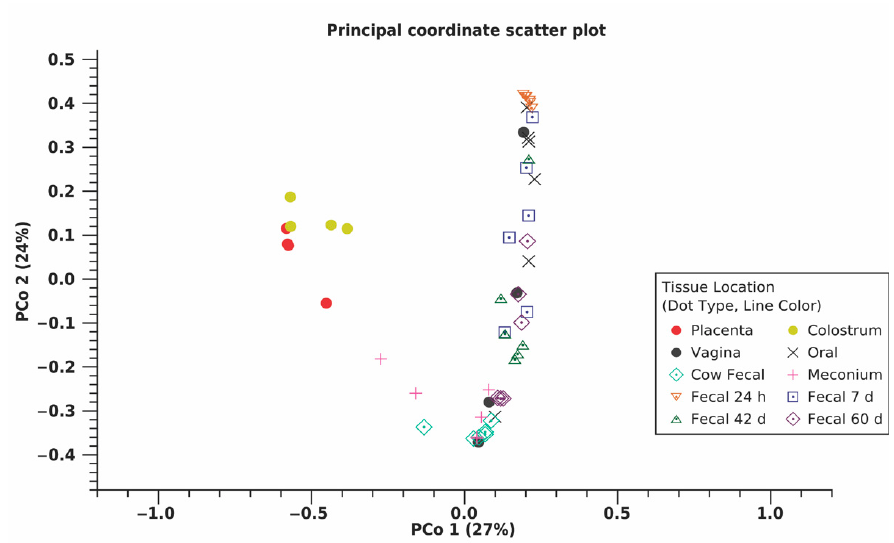
Figure 2. Principle coordinate (PCo) scatter plot using beta diversity or microbial diversity between samples, as measured by weighted Unifrac distances for each maternal (placenta, colostrum, oral, fecal, n = 6; vaginal, n = 4) and calf (meconium, 24 h, 7d, 42 d, and 60 d fecal; n = 6) microbiome sample type from multiparous Holstein cow–calf pairs. A permutational multivariate analysis of variance found there was a difference in beta diversity based on sample type ( p < 0.001). Placenta and colostrum clustered independently from other sample types, potentially due to low phylogenetic diversity within these samples. Meconium and dam fecal samples clustered closely. Clustering of fecal samples from 24 h to 60 d indicated calf fecal samples became more similar to dam fecal samples over time. Animals 2021 , 11 , x